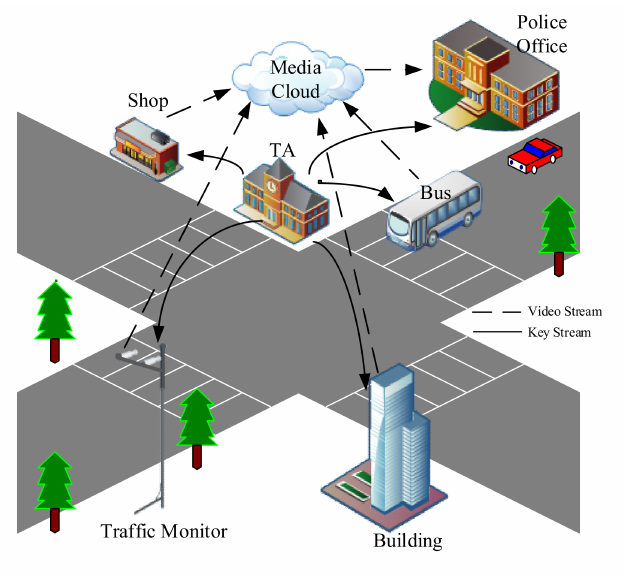
Figure 2. Secure video surveillance model in smart